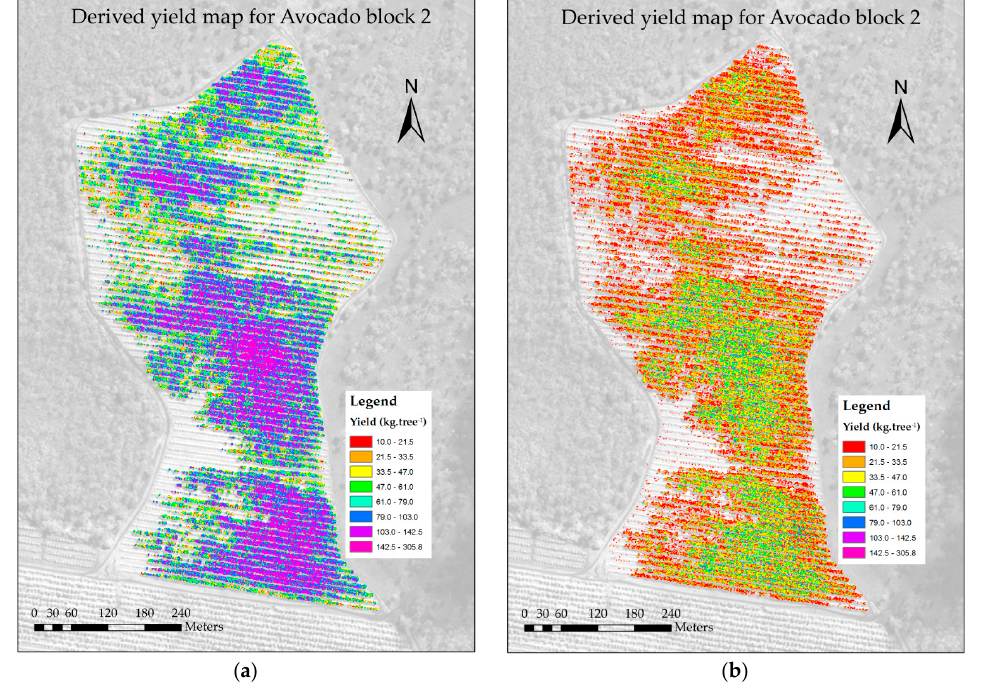
Figure 8. Classified yield maps derived from the best fit model of the relationship between VIs and total fruit weight (kg · tree − 1 ) for Block 2 in ( a ) 2016 and ( b ) 2017.